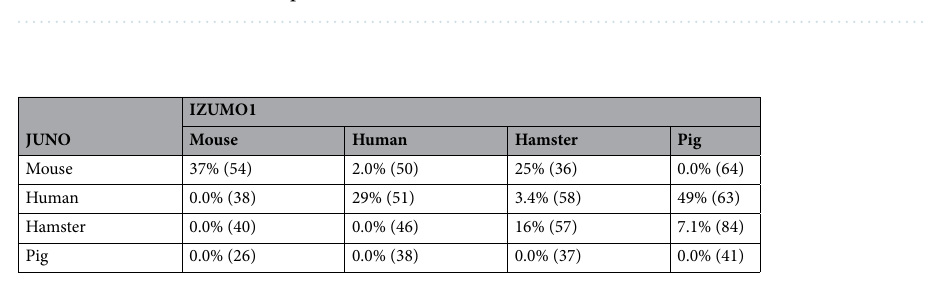
Table 1. IZUMO1 accumulation in conspecific and heterospecific cell combinations. Numbers in brackets are the numbers of contacted cell-pairs for each combination.